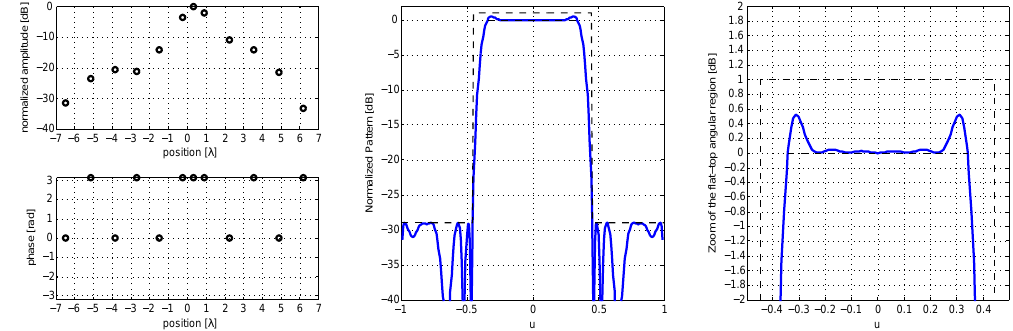
Figure 8. The third flat-top pattern achieved by means of SFGAP; from left to right : amplitude and phase of the excitations, power pattern of the array with its mask, highlight of the flat-top part of the